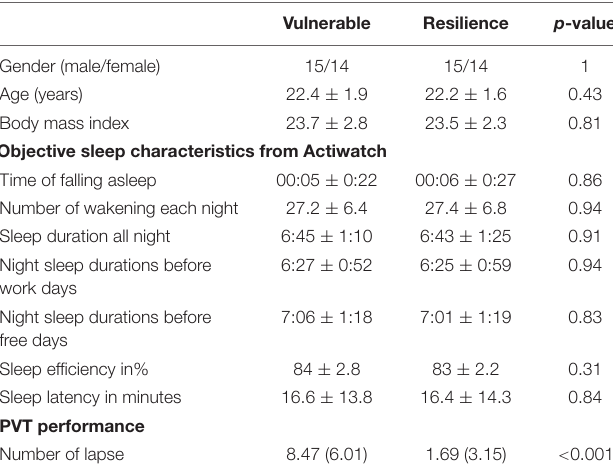
TABLE 1 | Demographic characteristics, objective sleep measures, and PVT performance.